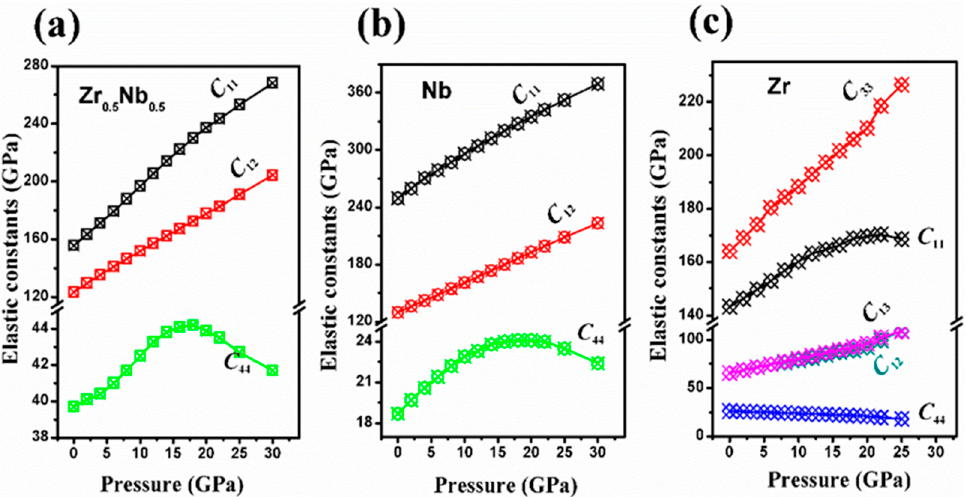
Figure 2. ( a ). Theoretical prediction of elastic constants ( C ij ) for cubic Zr 0.5 Nb 0.5 as a function of pressure, in comparison with those for cubic Nb ( b ) and hcp -Zr metals ( c ) end member of Zr-Nb alloys.